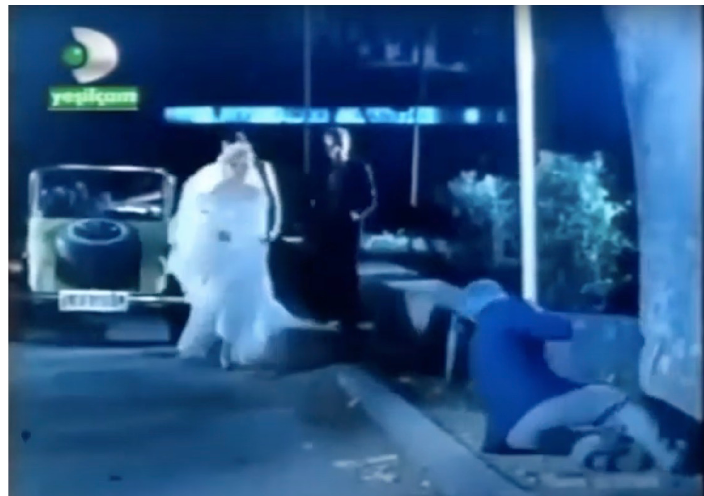
Figure 3: Esen finds a drunk Adnan in the streets on her wedding